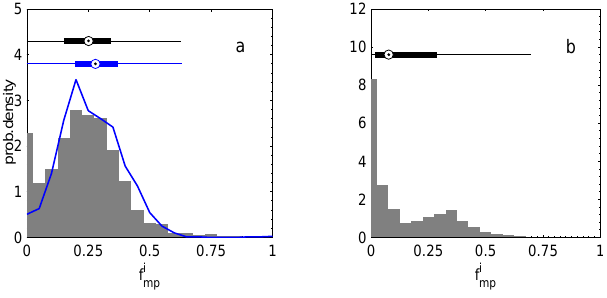
Figure 4. Empirical probability density of f i mp along the flight tracks 2 (a) and 6 (b) relative to the sea-ice area. For flight 2 image- based mean f mp of 25% and the quartiles Q 1 , 2 , 3 of 15, 25 and 34%, respectively, as shown by the box plot, image-averaged f ow = 9%. The blue line and blue box plot in (a) show the estimates of the same quantities of f mp = 28% and Q 1 , 2 , 3 = { 19 , 28 , 37 } from flight 2 images processed using the method of Renner et al. (2013). Figure 3. Along-track distribution of fractional melt-pond coverage For flight 6 image-based mean f mp = 15% and Q 1 , 2 , 3 = { 1 , 7 , 28 } , f i mp (light blue), bare ice f i (light grey) and open-water fraction image-averaged f ow = 37%. The whiskers on box plot highlight bi the 1.5 times interquartile range to cover some 99% of the observa- f i ow (blue), all relative to the image area, for flights 2 (very close tions in drift ice, a ) and 6 (marginal ice zone, b ). With a swath width of 35– 40m, the covered area corresponds to roughly 0.35–0.40km 2 per 10km flight track.